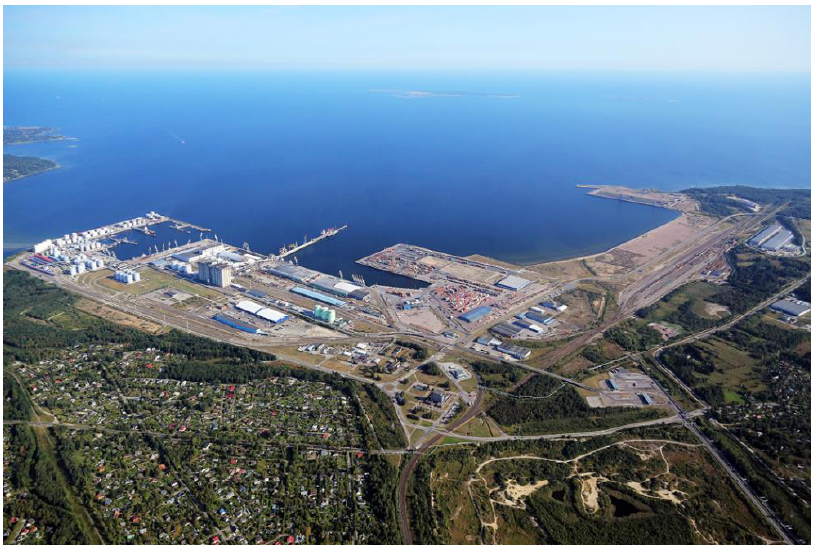
Figure 7. Muuga Harbour in Tallinn. Source: [74].